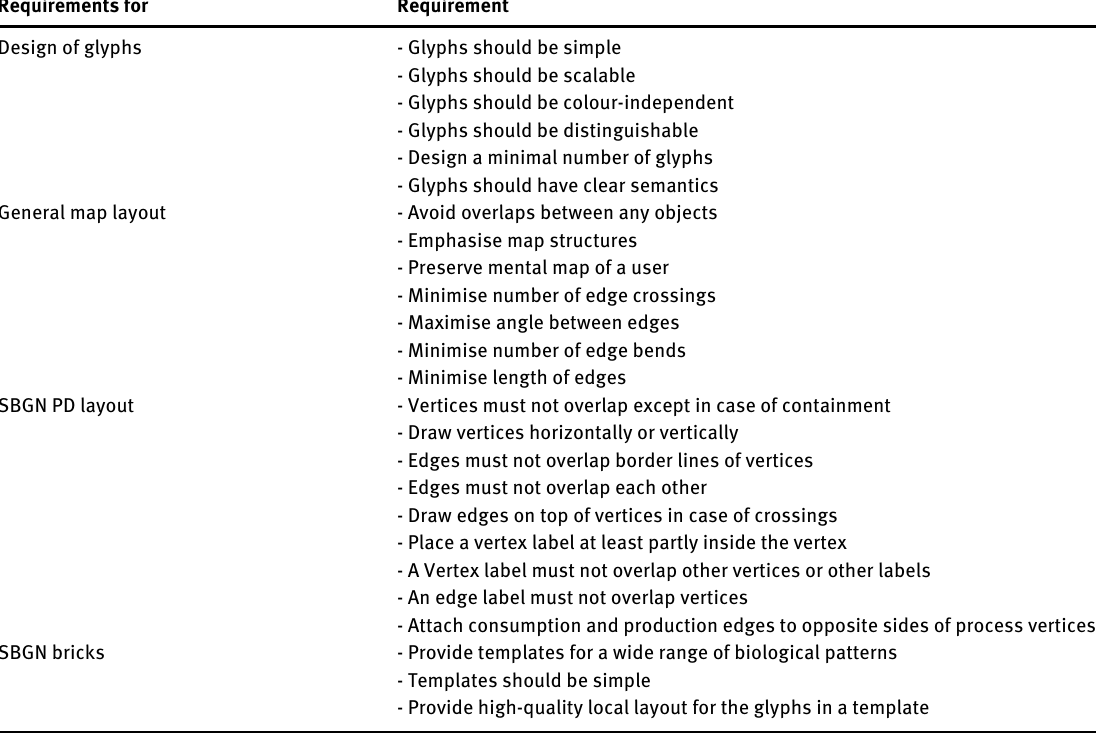
Table 1: Summary of requirements for the design of glyphs, general map layout, SBGN PD layout, and SBGN Bricks. Requirements